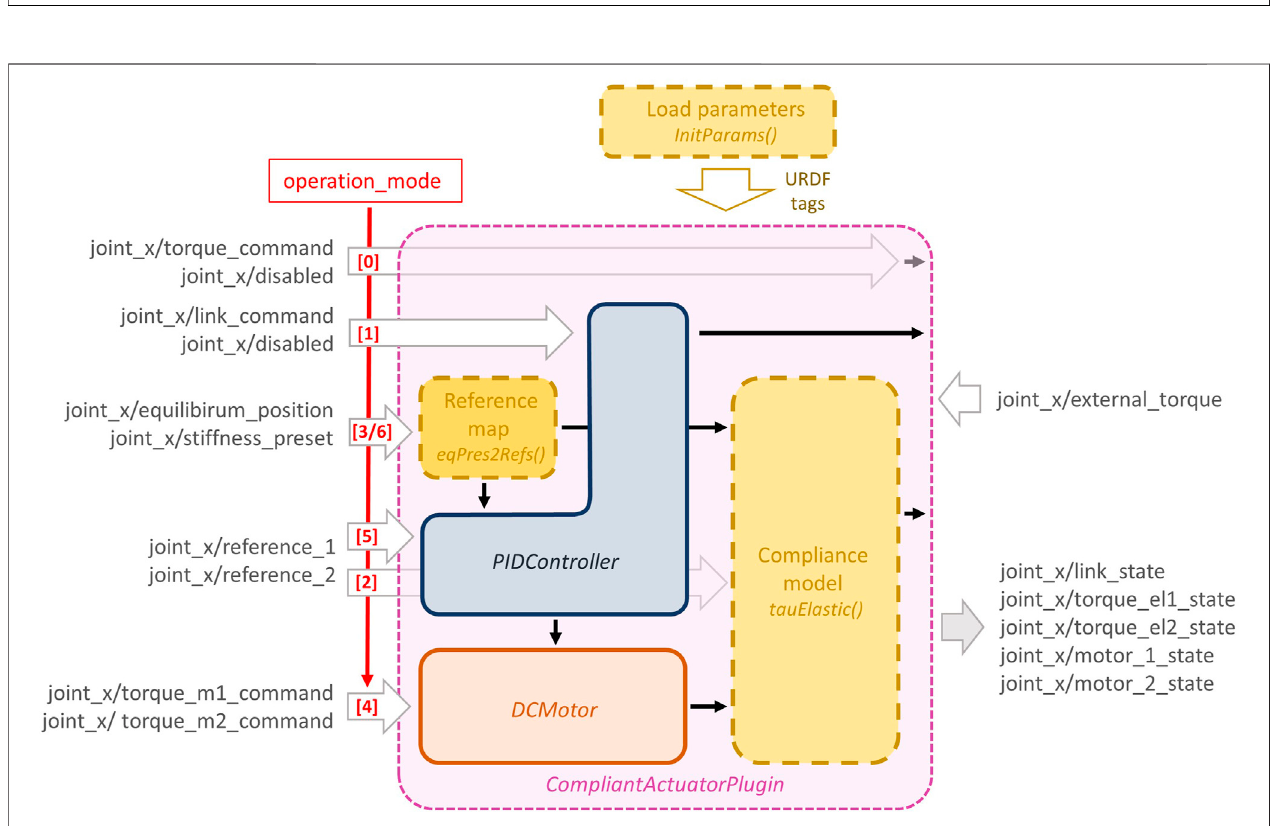
FIGURE 4 | The detailed structure of the CompliantActuatorPlugin , with its components and the topic names with which it interacts. The dashed yellow boxes reported in this fi gure are virtual functions (see Section 3.1.3 ) of the main C++ class that can be customized and should be implemented by the user, while the other blocks are used to simulate the motor dynamics and a simple PID control loop.